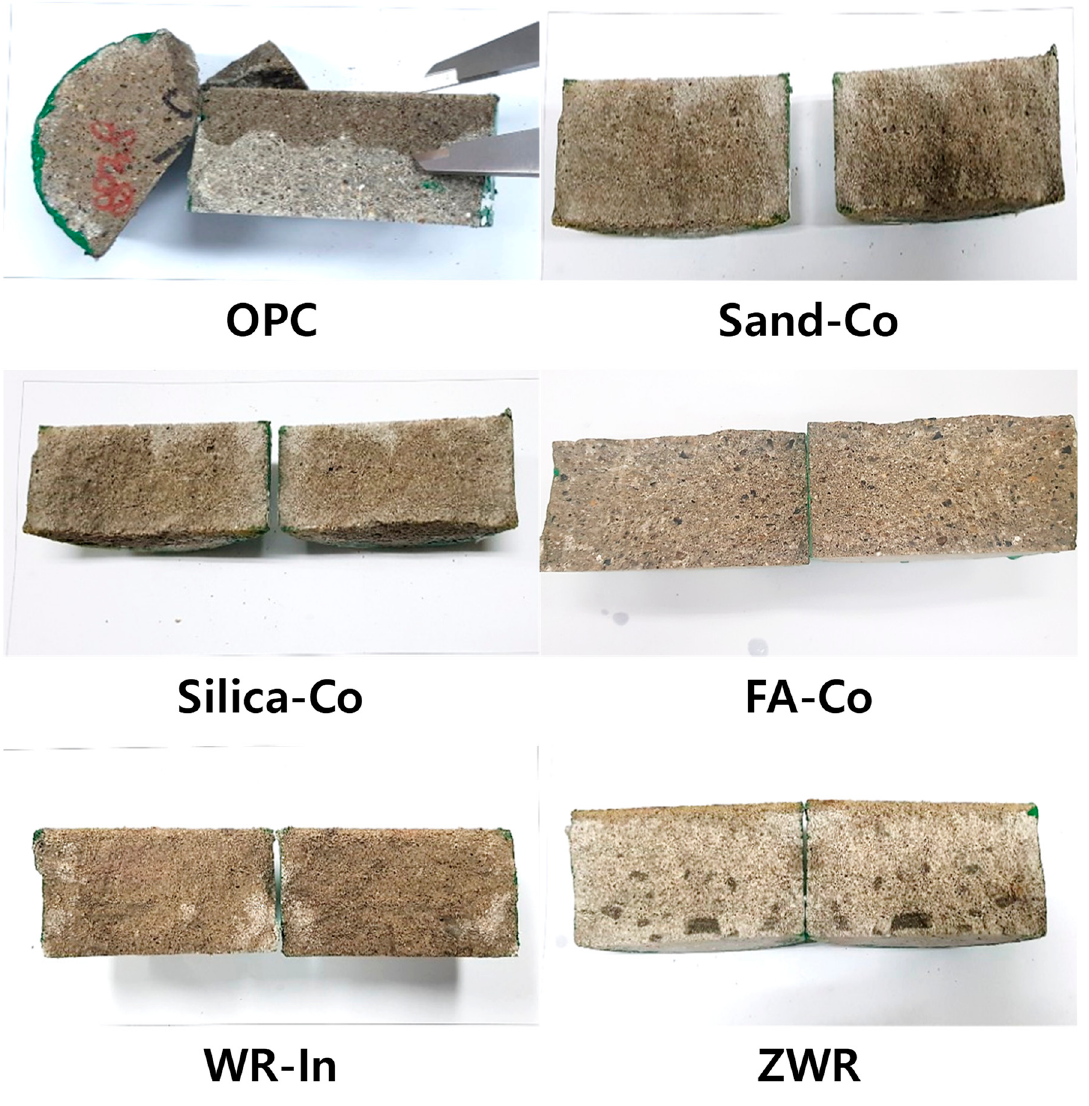
Figure 11. Result of the water penetration test specimen.